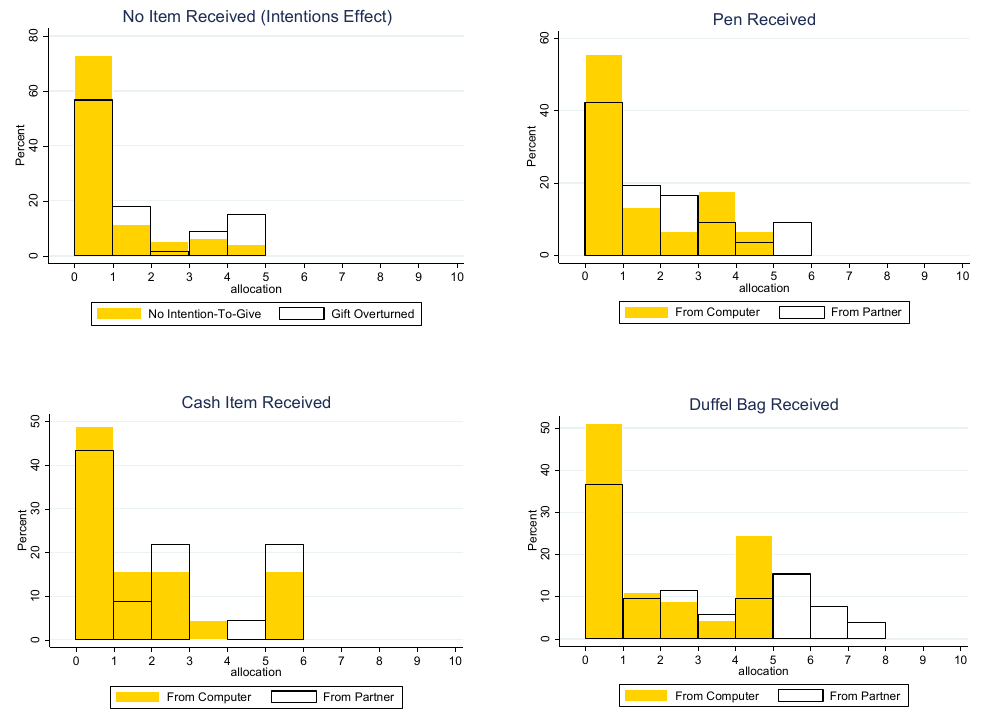
Figure A1. Distribution of Allocations by Item and Treatment.